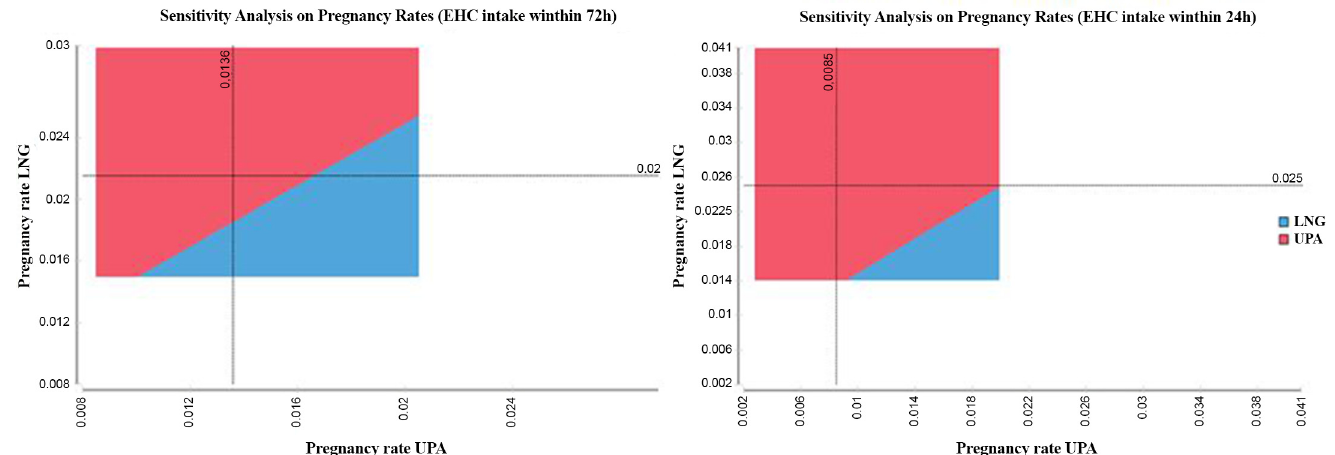
Fig 2. Two-way sensitivity analysis of the pregnancy rates of ulipristal acetate and levonorgestrel. UPA, ulipristal acetate; LNG, levonorgestrel; EHC, emergency hormonal contraception; Note: The colored area indicates which method is more cost-effective at a given pregnancy rate of UPA and LNG (for instance UPA is more cost-effective when the pregnancy rate of UPA is less than 1.36% and the pregnancy rate of LNG is more than 2.15% at intake within 72 hours). The dotted lines indicate the pregnancy rates observed in clinical trials, the whole area covers the 95% confidence intervals.